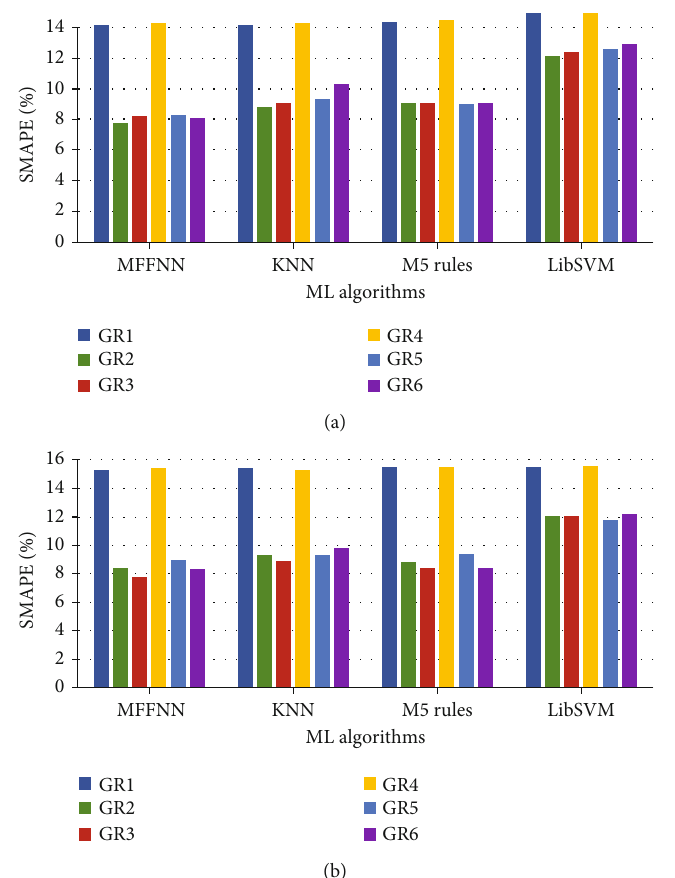
Figure 16: SMAPE performance comparisons for the best models developed by using ML algorithms according to data groups for (a) Kahramanmaras and (b)